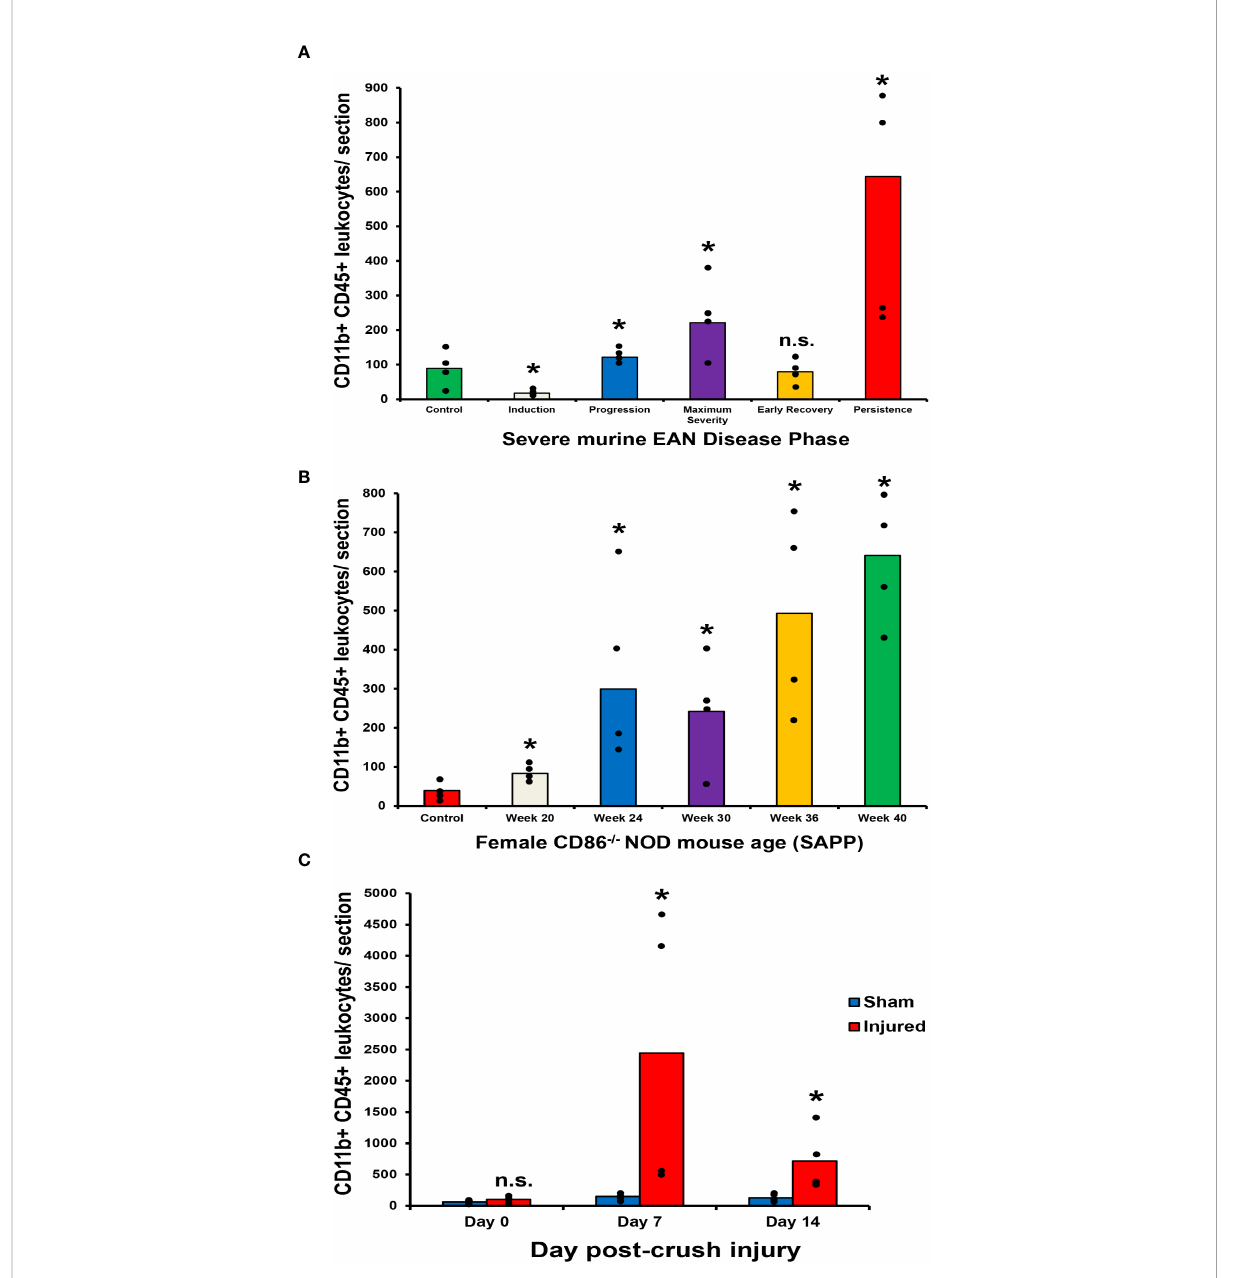
FIGURE 3 Sciatic nerve CD11b+ CD45+ leukocyte in fi ltration in murine peripheral neuropathy models. Bar histograms depict the mean endoneurial sciatic nerve CD11b+ CD45+ leukocyte counts per axial section (400X magni fi cation) relative to disease course in sm-EAN (A) , time (in weeks) in SAPP (B) and time (in days) following unilateral crush injury (C) are shown. In sm-EAN (A) , disease induction occurs within the fi rst 7 days following bovine peripheral nerve myelin inoculation, disease progression between days 7-21 and maximum severity between days 26-32. Early recovery occurs between days 33-40 post-inoculation with full recovery expected between days 55-65. Disease persistence refers to mice with appreciable muscle weakness on day 65 post-inoculation. Days 0, 15, 30, 37 and 65 post-inoculation are studied to represent these disease phases respectively. Statistically signi fi cant increases in mean CD11b+ CD45+ leukocyte counts are seen during sm-EAN disease progression, at maximum severity and with disease persistence relative to controls (A) . In SAPP, spontaneous disease onset is at 20 weeks of age and weakness persists throughout the life of affected mice. Signi fi cant increases in mean CD11b+ CD45+ leukocyte counts are seen relative to control mice without SAPP throughout the disease course (B) . Following unilateral sciatic nerve crush injury, signi fi cant differences in mean CD11b+ CD45+ leukocyte counts are seen on day 7 (at the time of maximal sciatic nerve Gdnf expression) and day 14 (during the early recovery phase associated with restoration of blood-nerve barrier impermeability and early axonal regeneration in WT mice) compared to uninjured (Sham control) nerves from the same mice (C) . *p < 0.05. n.s. not signi fi cant, N =